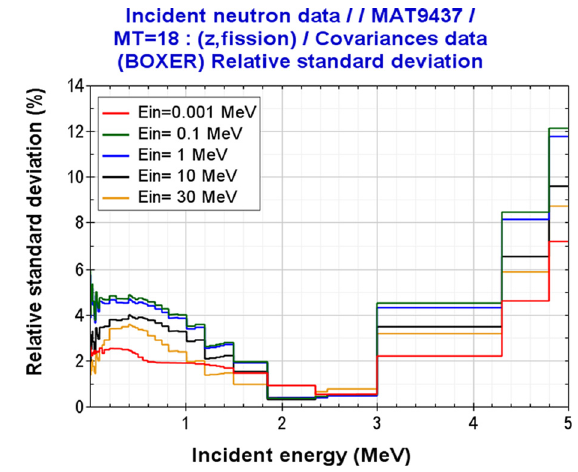
Fig. 5. RSD in % of 239 Pu/JEFF-3.3T4 PFNS distributions as a function of mean incident neutron fi ssion energy.